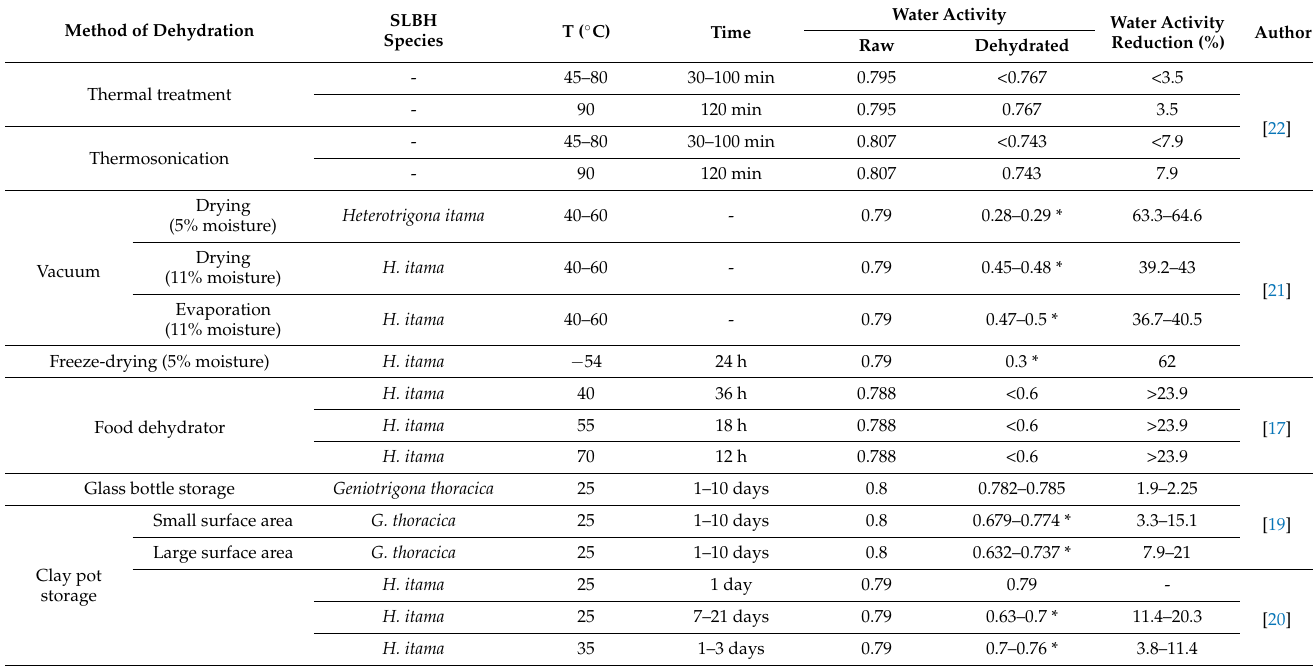
Table 2. Water activity of raw and dehydrated stingless bee honey